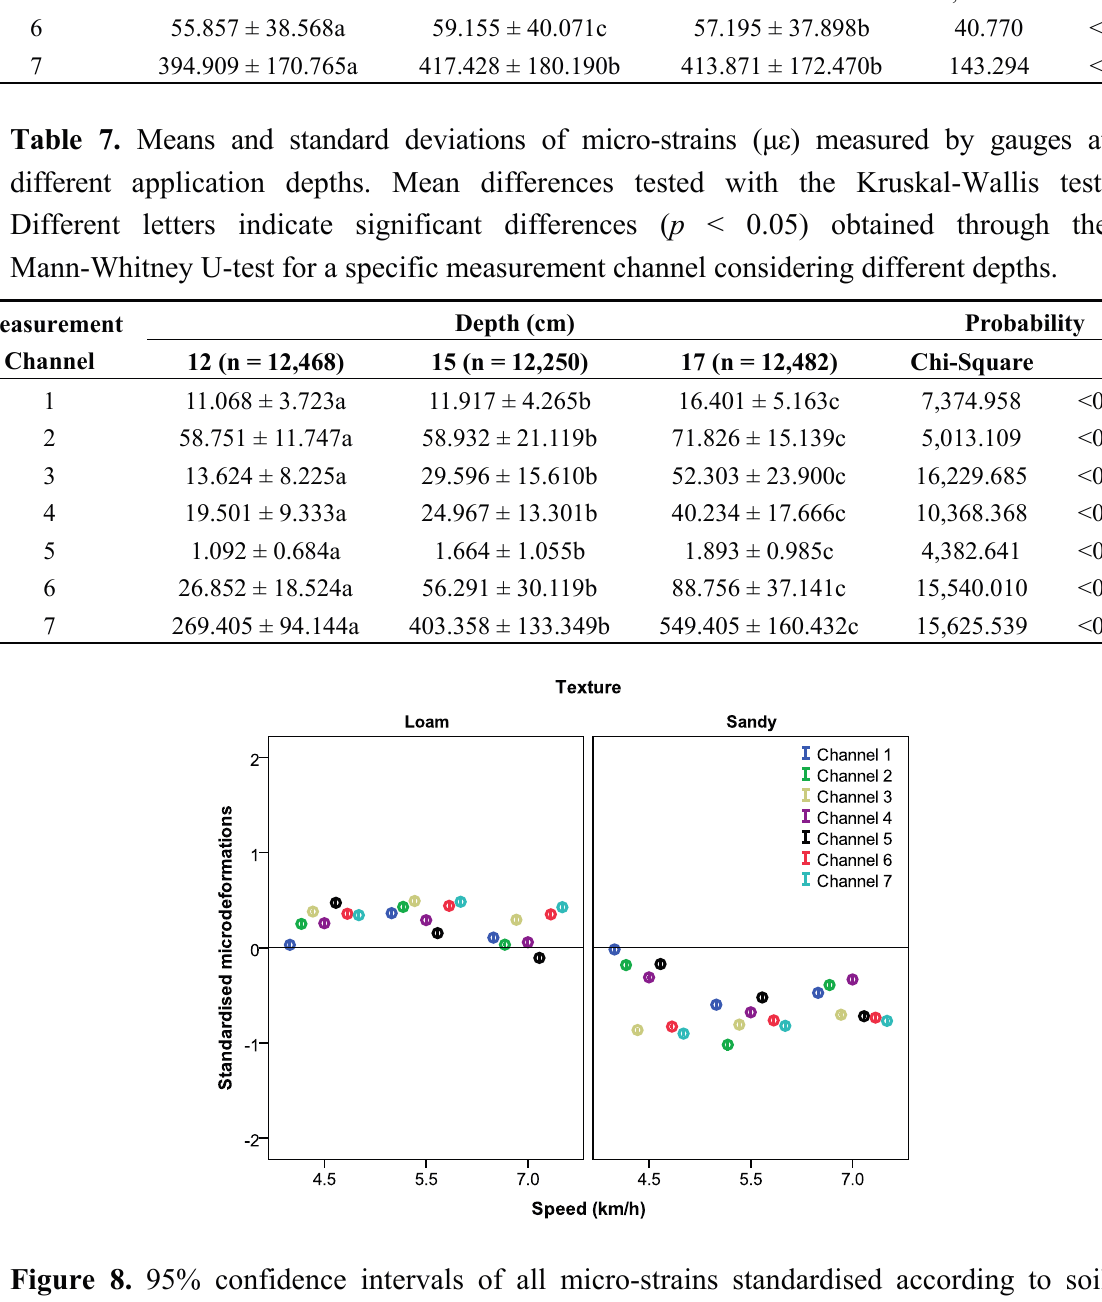
Figure 8. 95% confidence intervals of all micro-strains standardised according to soil texture at different forward